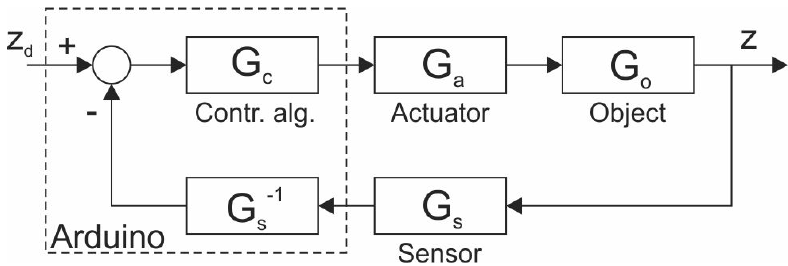
Figure 10. The role of the microcontroller (Arduino) in the